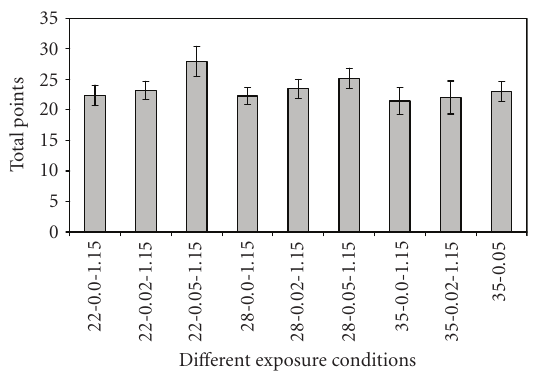
Figure 8: The average number of holes visible to all the observers under 9 di ff erent conditions with the 2 . 15 cm phantom. In each condition (the horizontal axis), the first number represents the X- ray energy (kVp) and the second number represents the thickness (in mm) of the Mo filter. It shows that the X-ray image taken using 22 kVp and 0 . 05mm Mo filter has the highest total points (27 . 73). The error bars indicate the standard errors for the means of the points under each